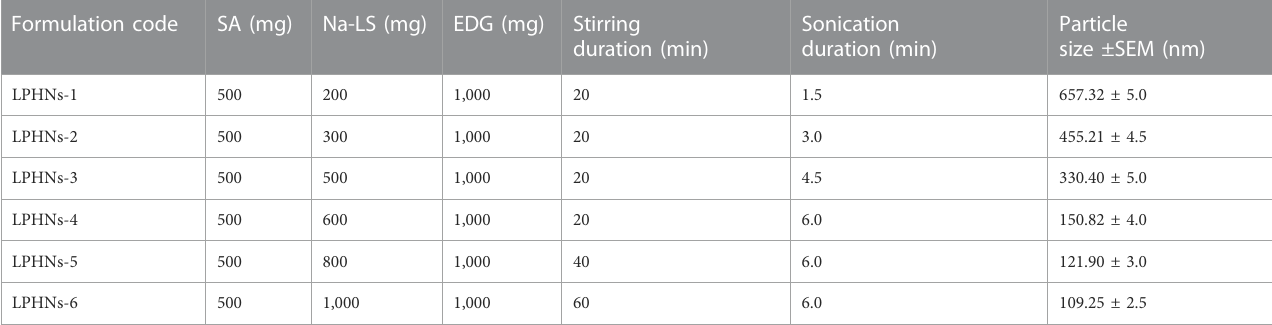
TABLE 1 Preparation and optimization of unloaded lipid polymer hybrid nanoparticles (LPHNs) nano-formulations. Formulation